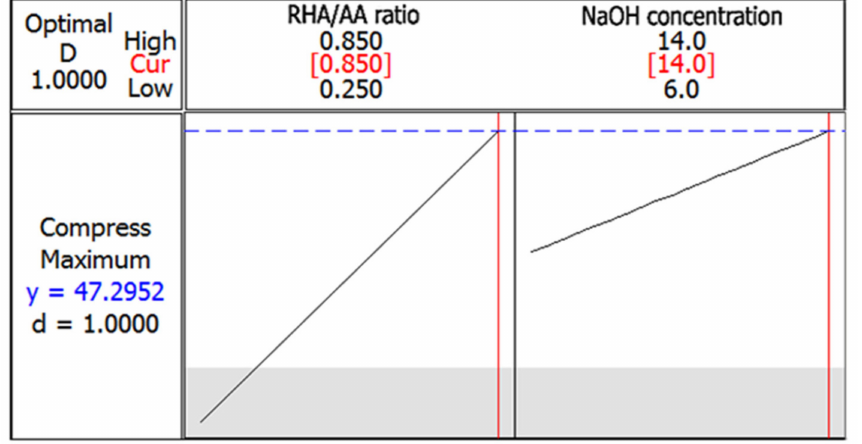
Figure 8. Optimization plot in compressive strength